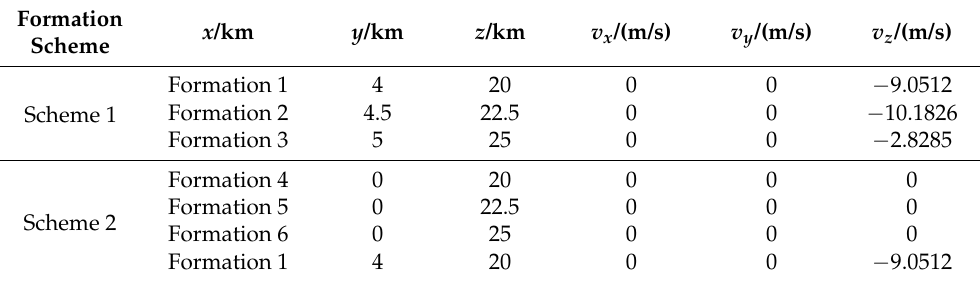
Table 1. Initial relative orbital parameters of nano-satellites.